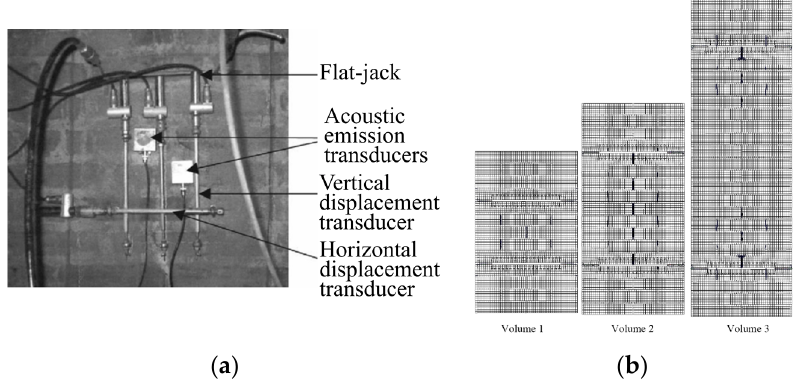
Figure 12. ( a ) Double flat jack experimental set; ( b ) numerical discretization and crack patterns for increasing distance between the flat jacks. Appl. Sci. 2016 , 6 , 102